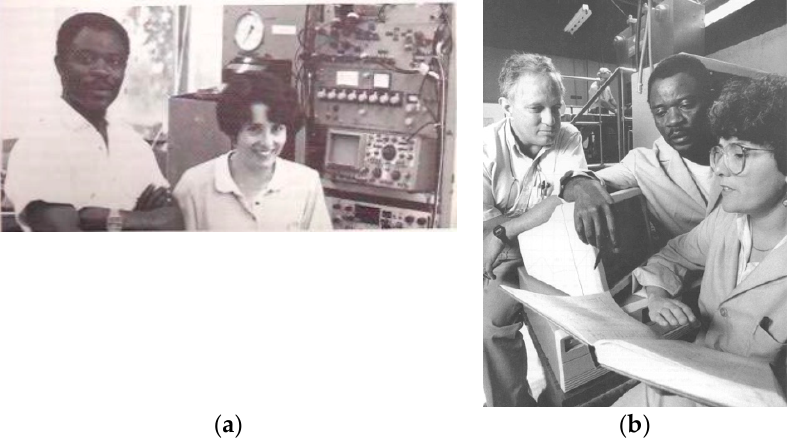
Figure 2. ( a ) Gabriel Gwanmesia and Sally Rigden with the ultrasonic interferometer in Ian Jackson’s laboratory at the ANU. ( b ) Sally Rigden from the ANU with Gabriel Gwanmesia and the author in High Pressure Laboratory at Stony Brook in 1991. Reproduced with permission from Liebermann [1], published by Elsevier B.V., 2014.